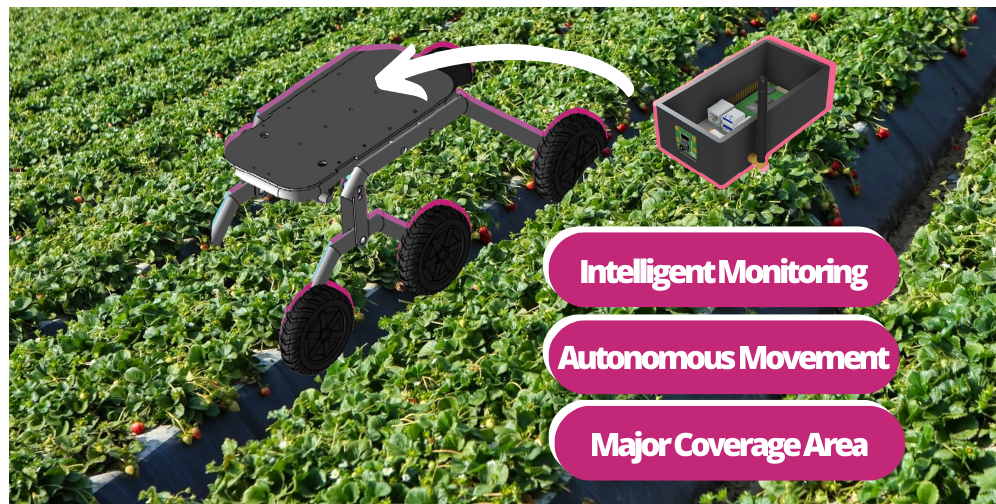
Figure 15. Possible application of the collector node.